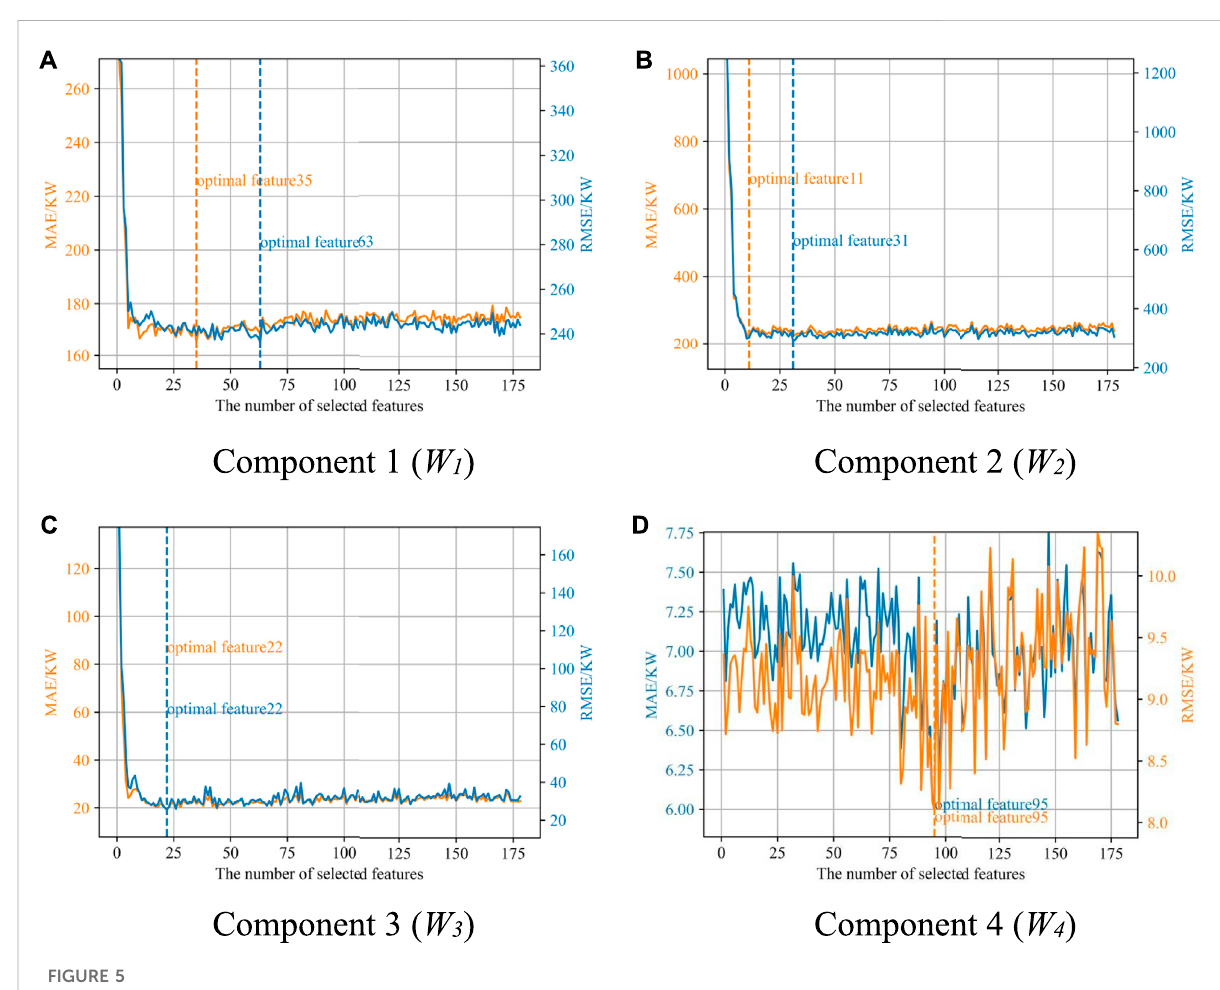
FIGURE 5 Forecasting errors with differentnumbersof inputfeaturesfor four componentsas examplesincluding (A) Component1, (B) Component2, (C) Component 3, and (D) Component 4.